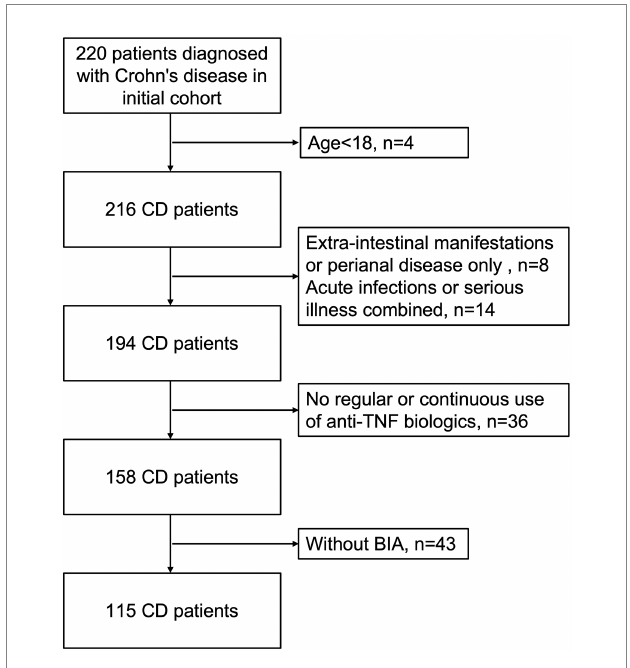
FIGURE 1 Study flow chart explaining the CD patients’